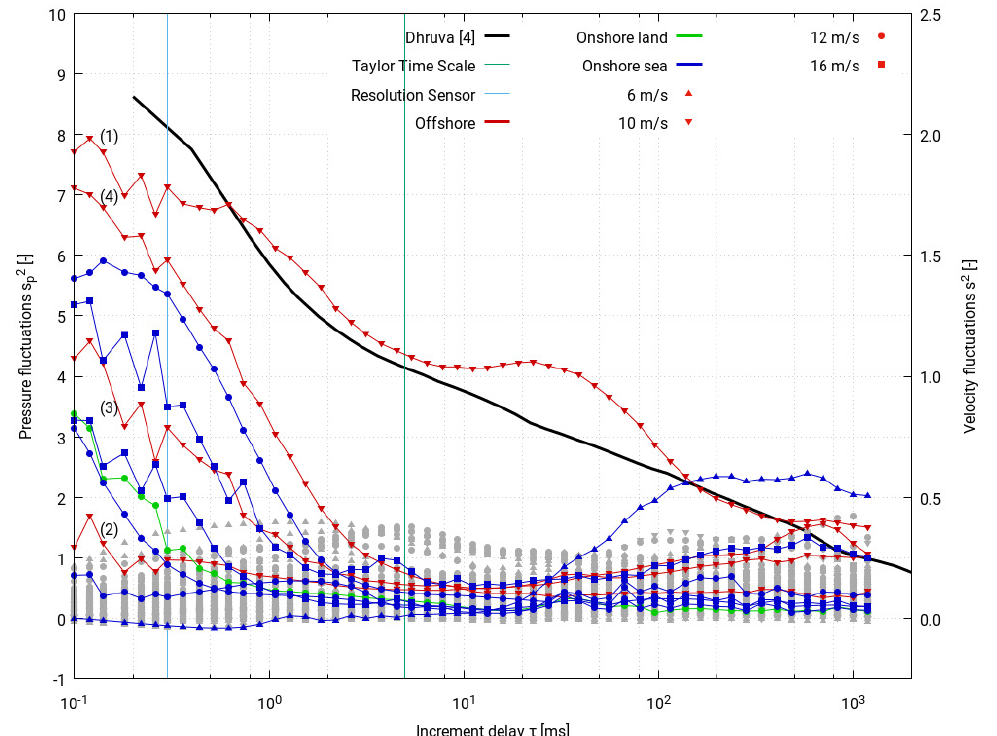
Figure 4. Shape parameters for all collected measurements. Colors represent locations: offshore, onshore with wind coming from land or sea side. The symbols represent the velocity classes for the wind speed. Measurements with max ( s 2 p ) < 2 are shown in grey. For reasons of comparison, Taylor’s and Kolmogorov’s time scales are given in 5 msec and 0.05 msec, respectively. The sensor’s resolution goes down to approximately 0.3 msec